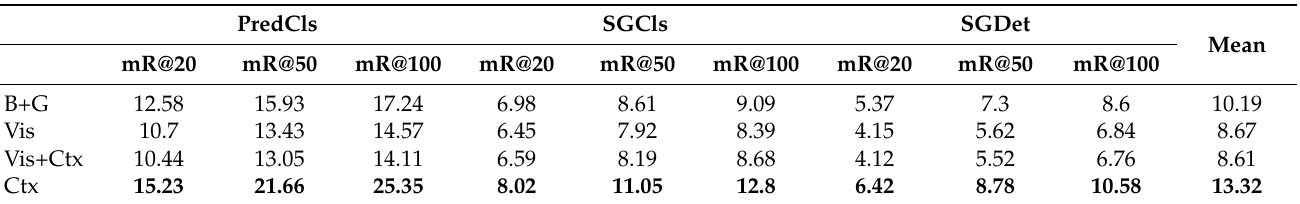
Table 7. Visual dependency reduction in terms of mR@K. Vis refers to applying L visual , while Ctx refers to applying L context